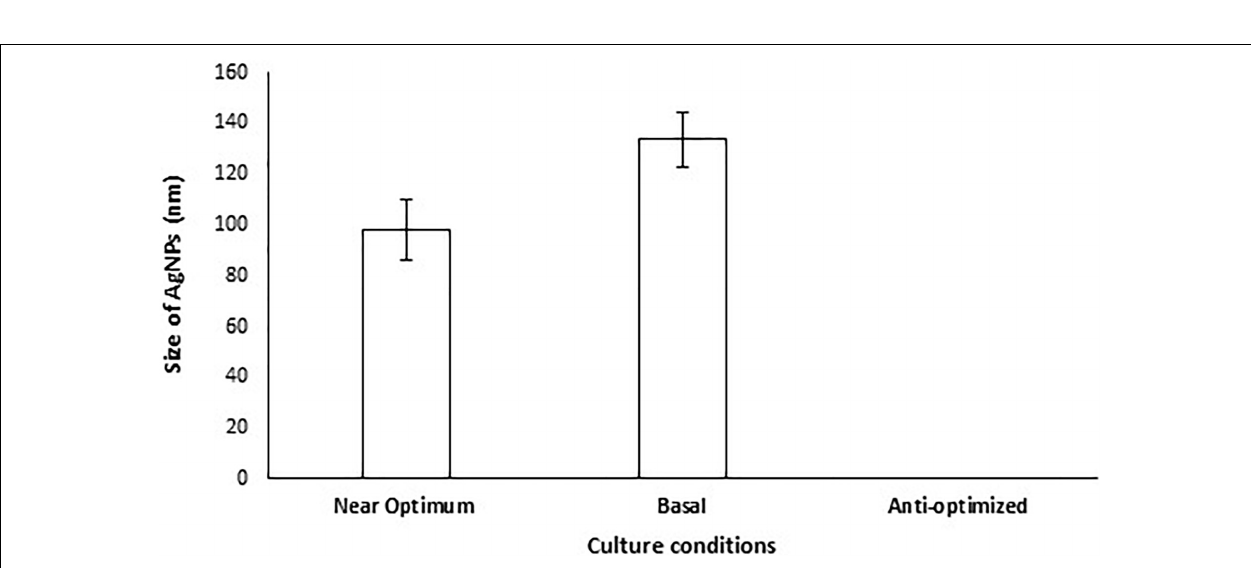
FIGURE 3 | Size of AgNPs mycosynthesized by A. terreus BA6 in basal, anti-optimized and optimized culture conditions.